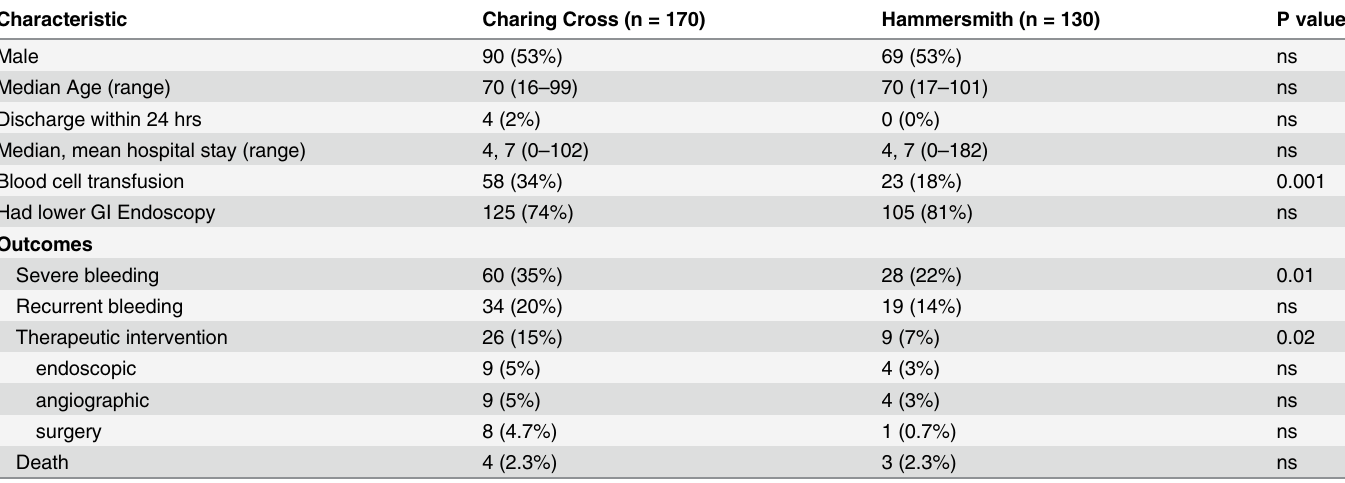
Table 2. Characteristics and outcomes of cohorts.